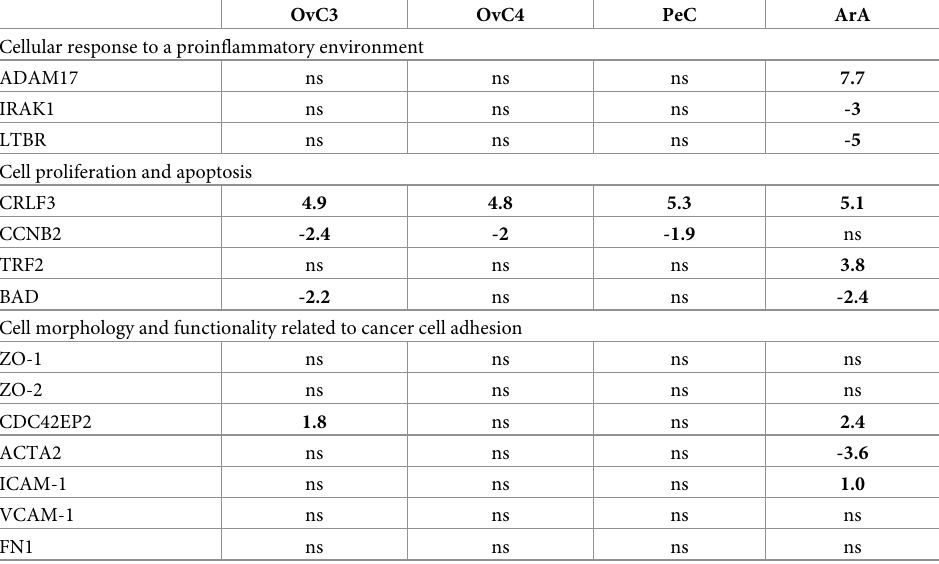
Table 2. Binary logarithm of the ratio of treated to untreated cells.